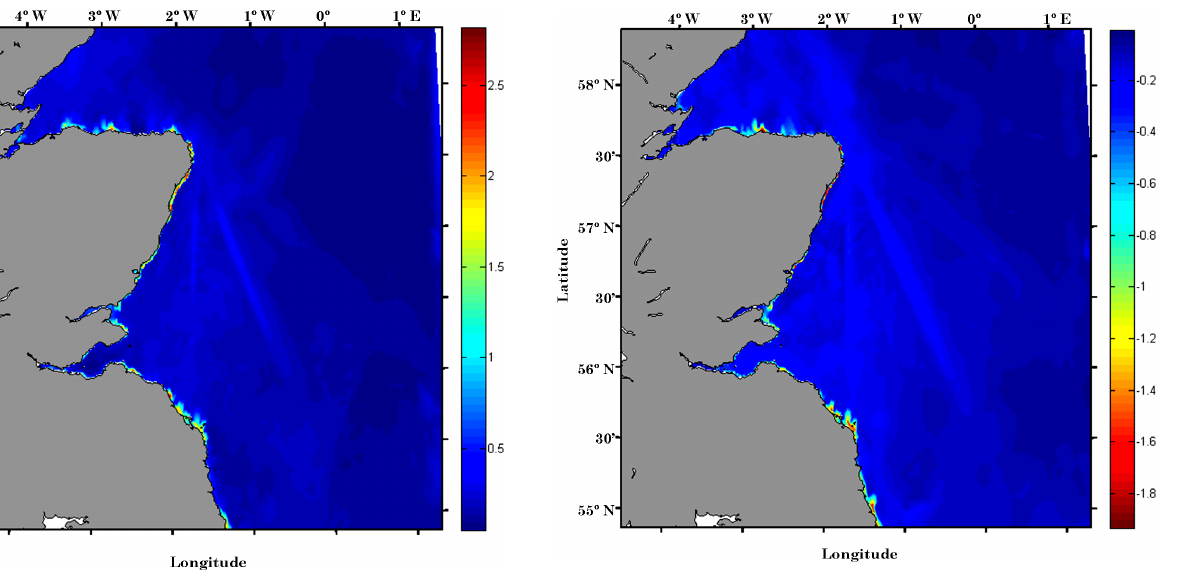
Figure 5. Maximum modelled positive deviation of the H s (m) due to the WCIs recorded in the 7-month period run in 2010.